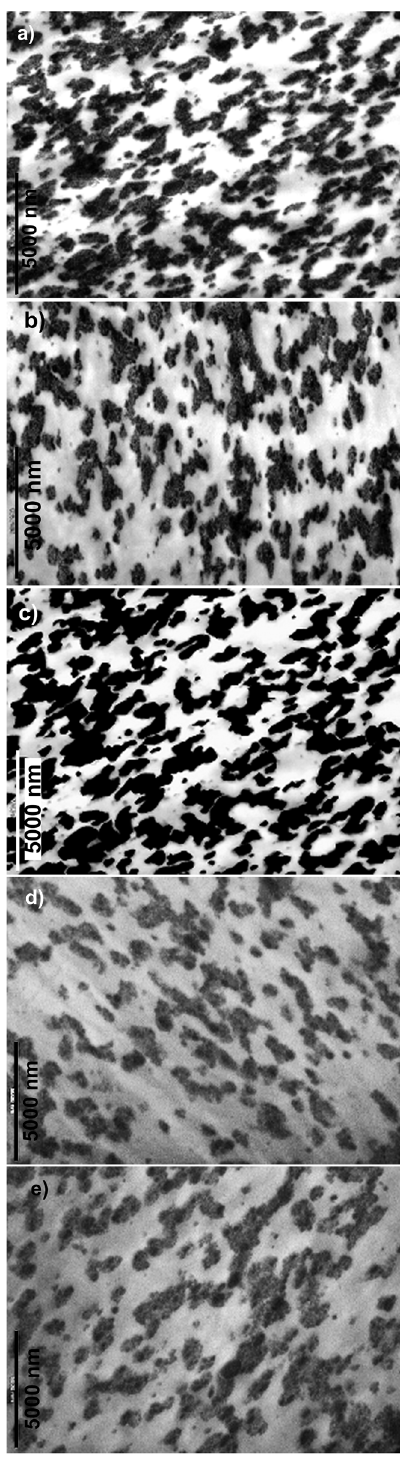
Figure 4. Micrographs obtained by TEM from PBT/ ABS blend processed with screw 4KB45/5/42 and 7.0 kg/h, where: a) Sample 120 rpm and die with 2.00 mm, b) Sample 240 rpm and die with 2.00 mm c) Sample a) binarized for dispersion calculation, d) Sample 120 rpm and die with 62.00 mm and e) Sample 240 rpm and die with 62.00 mm.